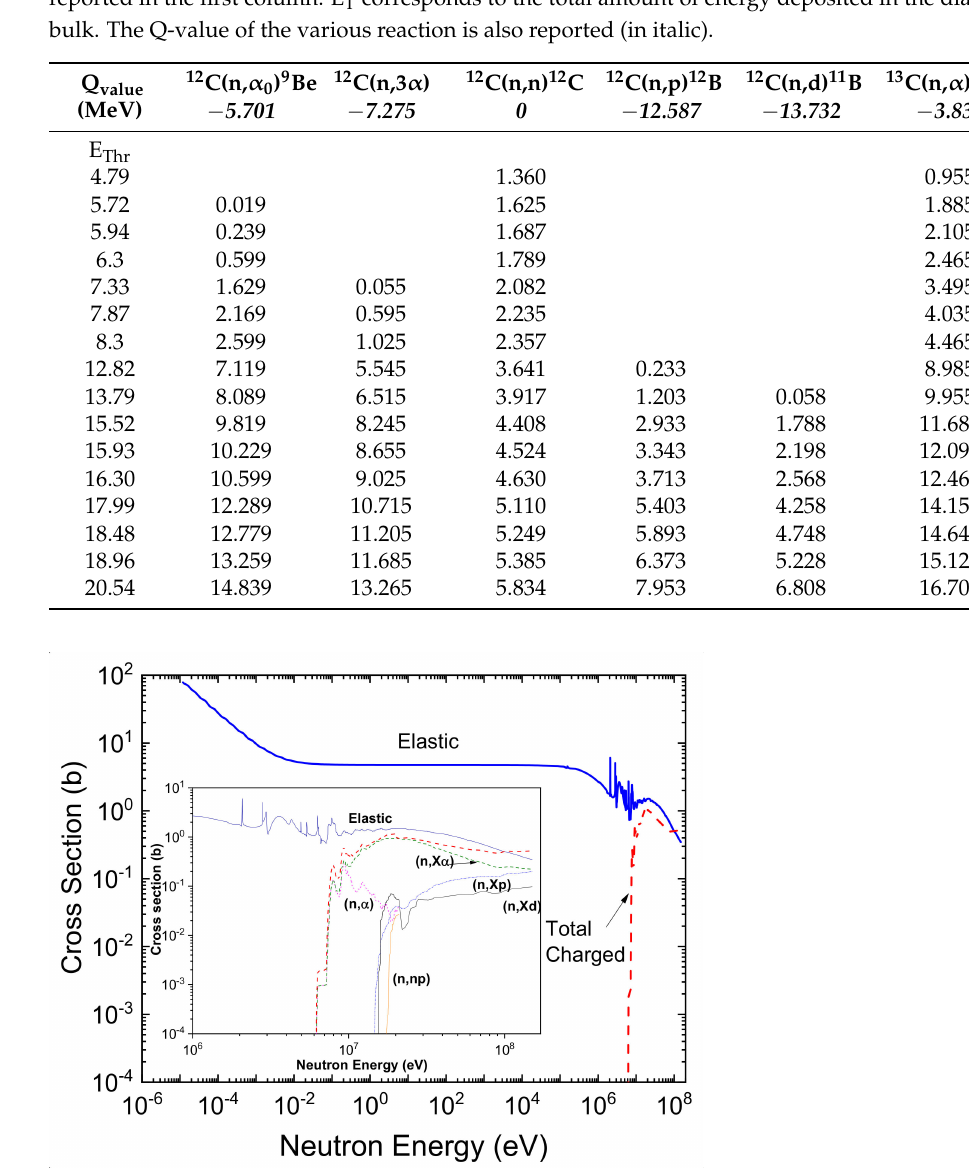
Figure 14. Elastic and total charged cross-sections for diamond. The inset shows the charged particle reaction cross-sections occurring for E n > 5 MeV (see Table 3) compared to the elastic scattering